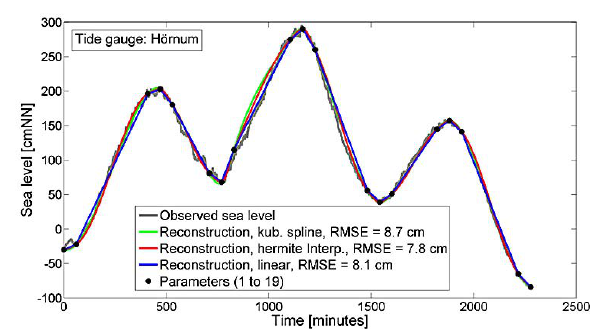
Fig. 7. Results from parameterising and reconstructing a selected storm surge event by applying different interpolation methods to reconstruct the observed storm surge